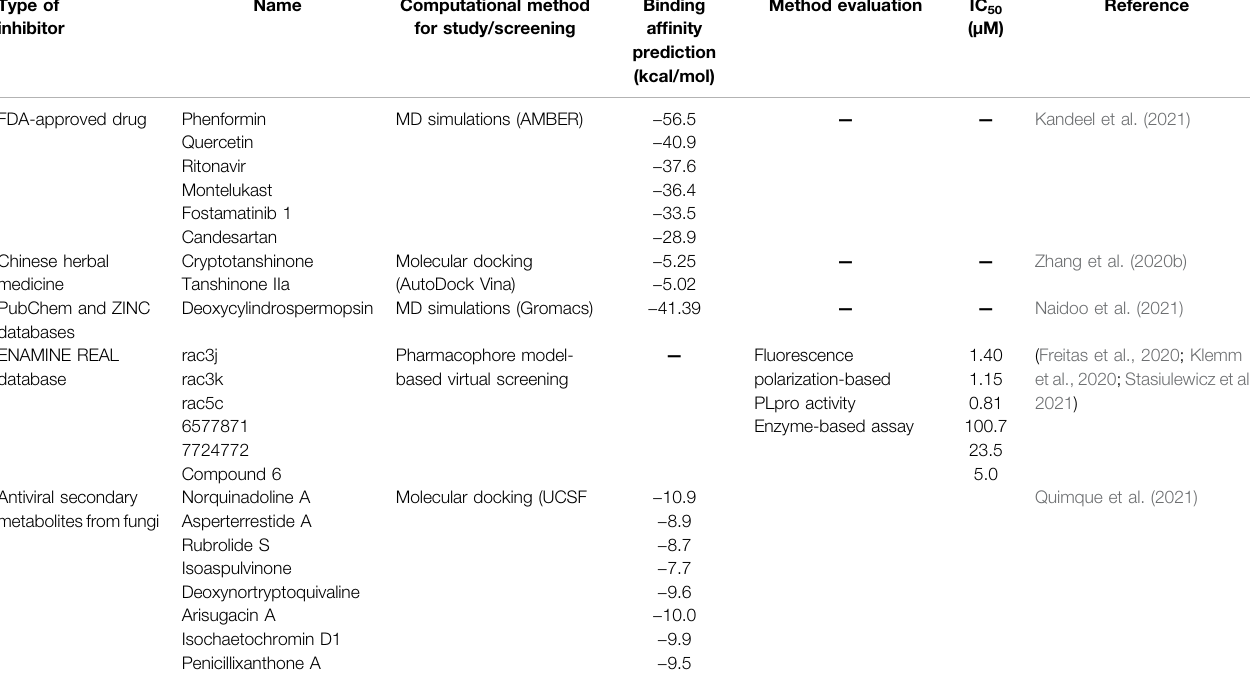
TABLE 6 | Inhibitors against SARS-CoV-2 PLpro derived from in silico